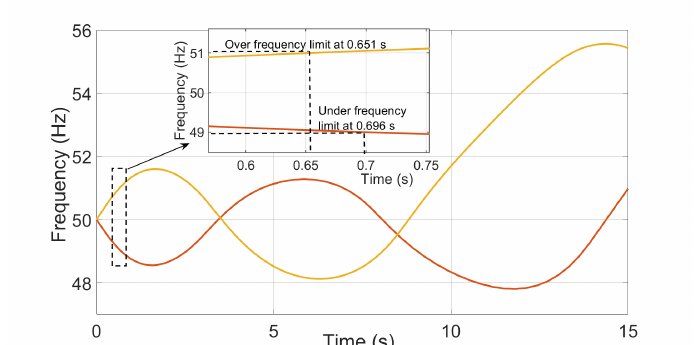
Figure 17. Under and over-frequency events in the extended IEEE model: a difference of 45 ms between each critical time was